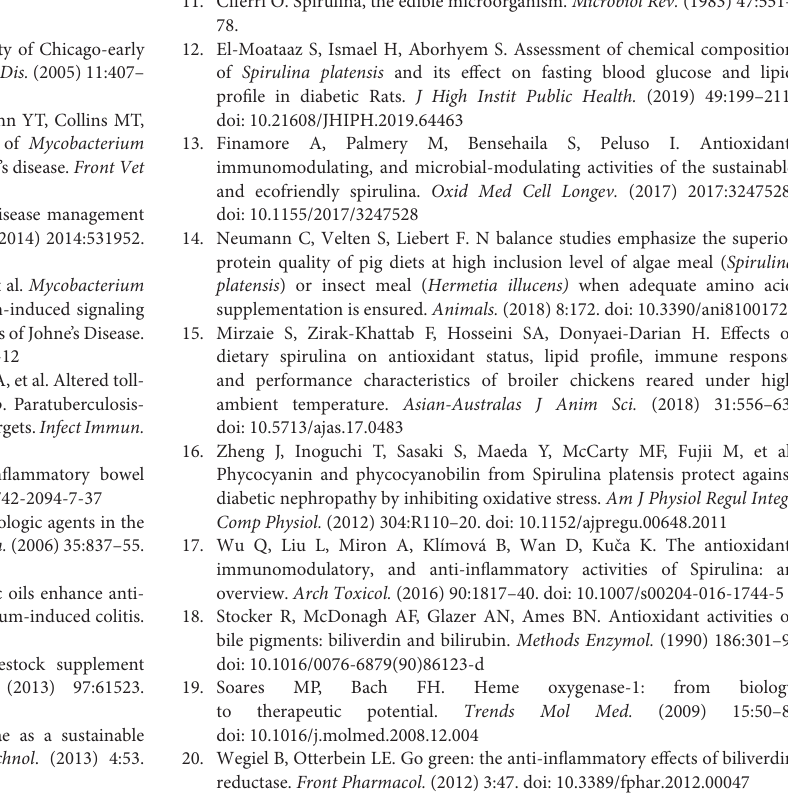
Supplemental Figure 1 | Representative histological images of different intestinal segment. Sections were stained with hematoxylin and eosin and viewed at X40 magnification with scale bars indicating 500 µ m. Supplemental Figure 2 | Species accumulation curve. Data were presented as mean ± S.D. Supplemental Figure 3 | Effect of SP1, SP2, MBV-SP1, and MBV-SP2 feed on broiler gut Firmicutes / Bacteroidetes (F/B) ratios. Data were presented as mean ± S.D. Supplemental Figure 4 | Partial Least Squares Discriminant Analysis of the cecal contents. Control (basal diet); AMX, basal diet plus 0.1% amoxicillin; SP1, basal diet plus 0.05% microalgae; SP2, basal diet plus 0.1% microalgae; MBV-SP1, basal diet plus 0.05% MBV-enriched microalgae; MBV-SP2, basal diet plus 0.1% MBV-enriched